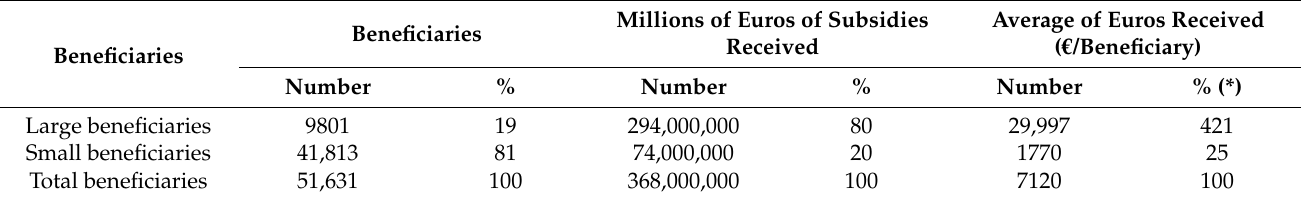
Table 4. Distribution of beneficiaries of EU subsidies in Catalonia (2015). Source: Soler and Duch, 2017.